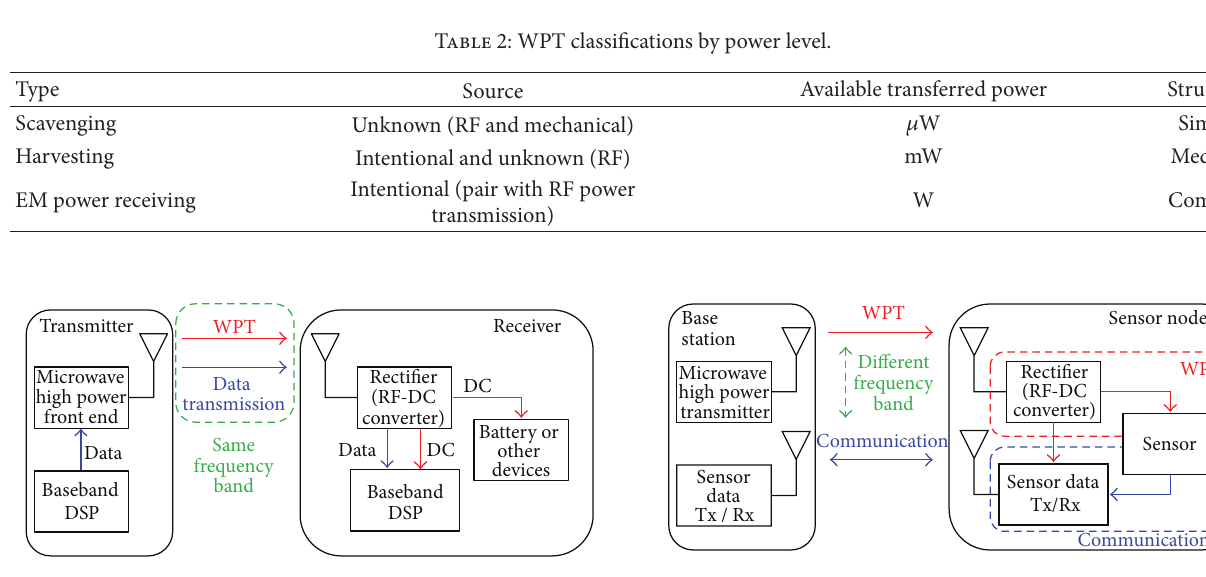
Figure 2: A conceptual illustration of WiSEnT technology using the microwave